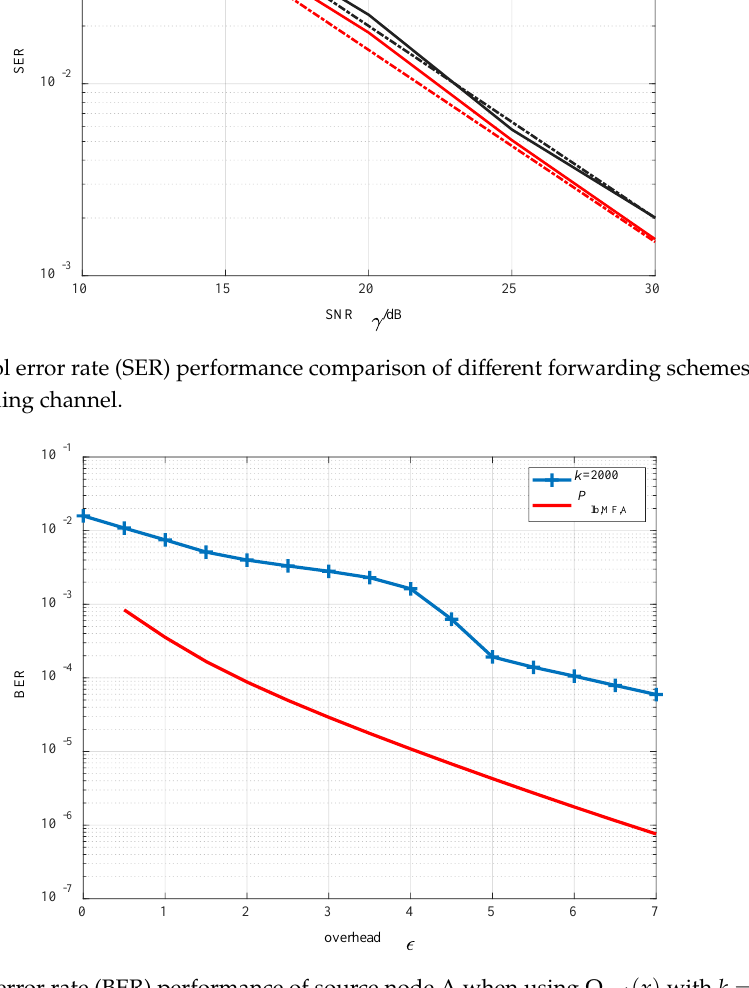
x with =2000 k . opt